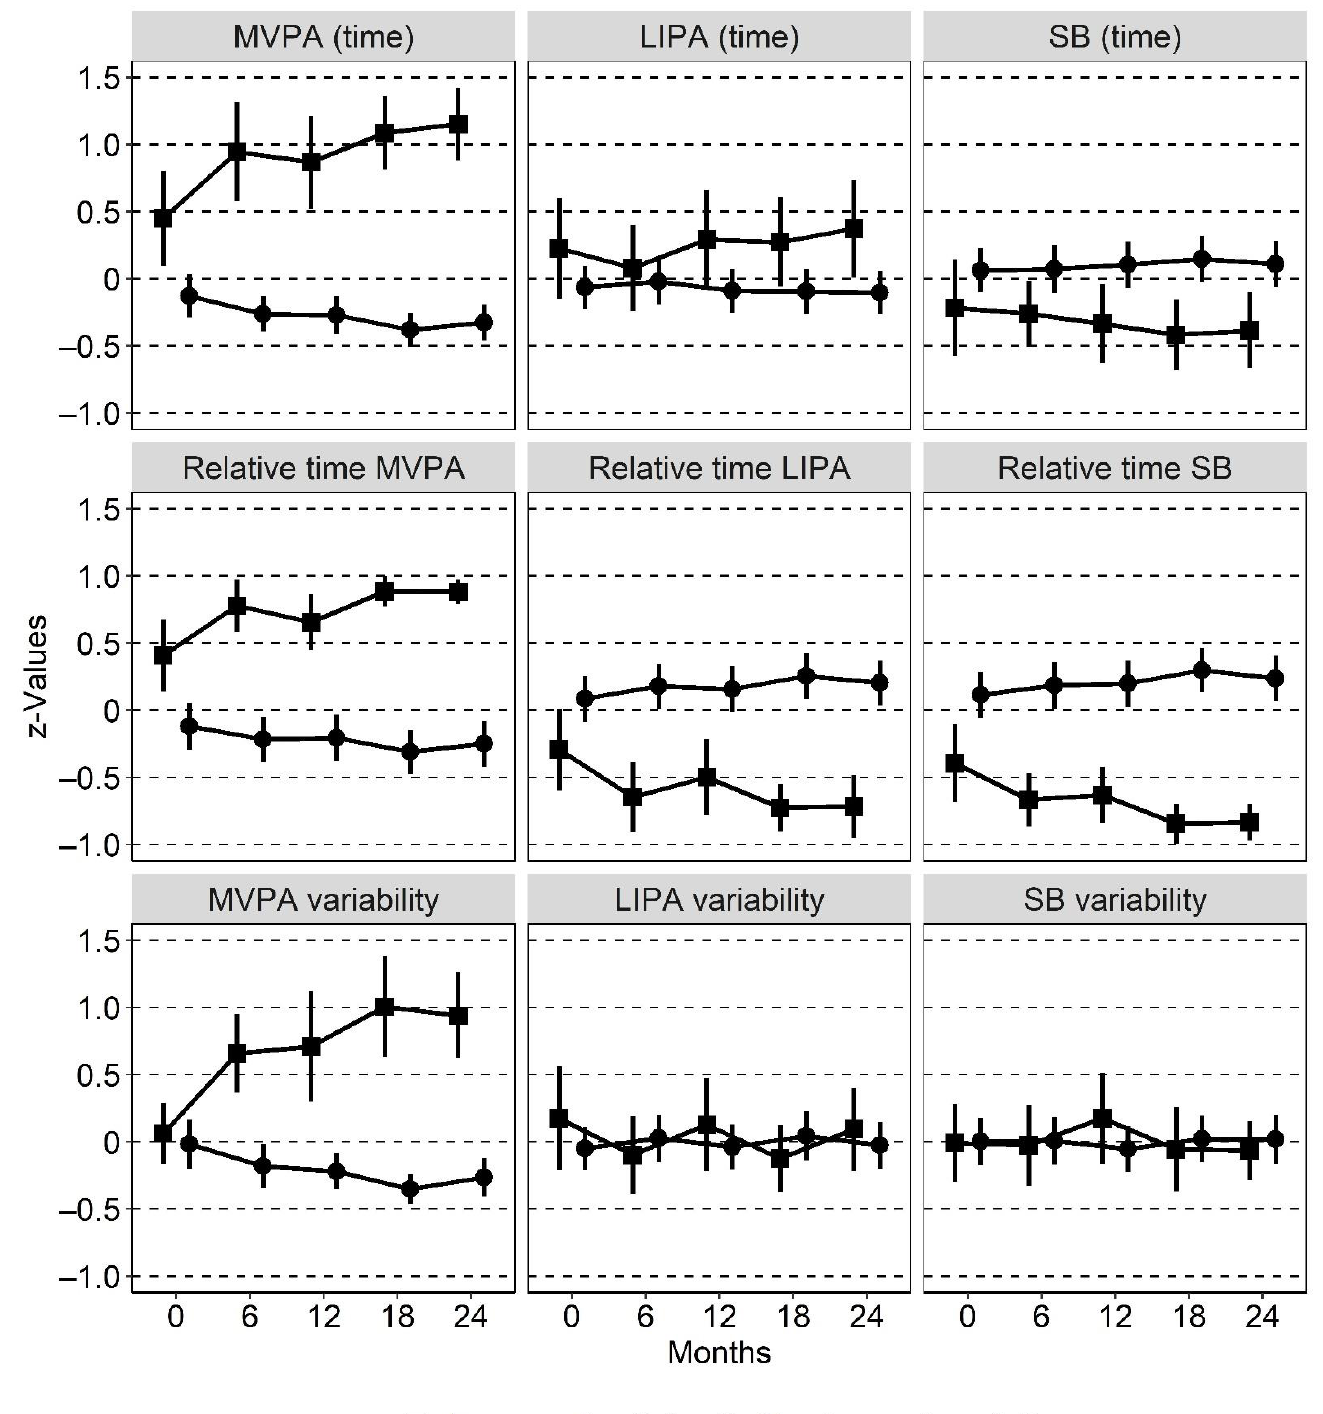
Figure 1. Line plots with 95% confidence intervals as error bars for PA and SB variables by profile membership across time. LIPA, light intensity physical activity; MVPA, moderate-to-vigorous physical activity; SB, sedentary behaviour. “Time” refers to absolute time for each behaviour, “relative time” refers to time in one behaviour relative to the two remaining behaviours and “variability” refers to the standard deviation of one behaviour across the days it was measured. All data are presented as z -values.